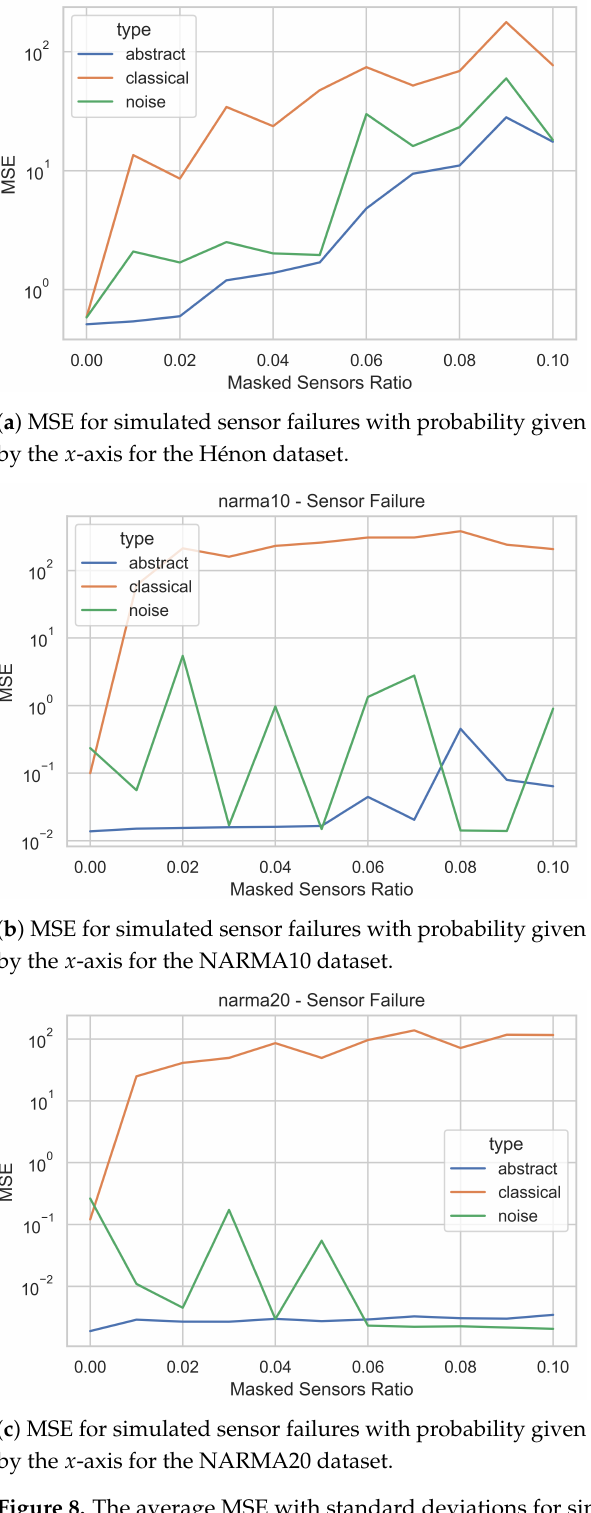
Figure 8. The average MSE with standard deviations for simulated sensor failures for the